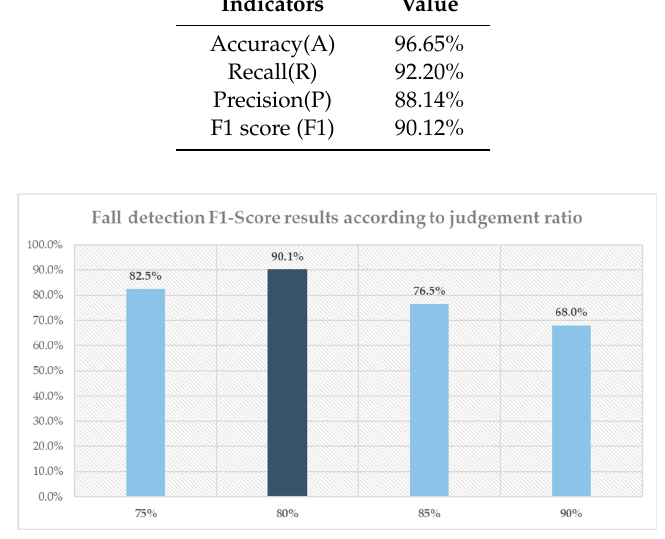
Figure 14. F1 score results of fall detection according to standard ratio.